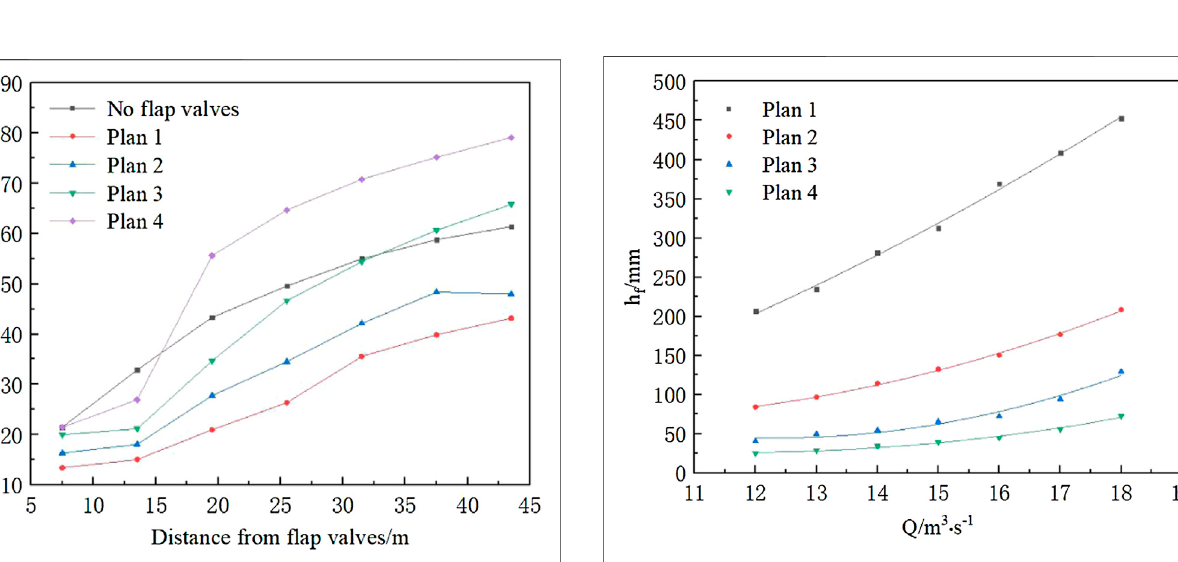
FIGURE 12 | Vector diagram of cross-section velocity: (A) case 1, (B) case 2, (C) case 3, and (D) case 4.